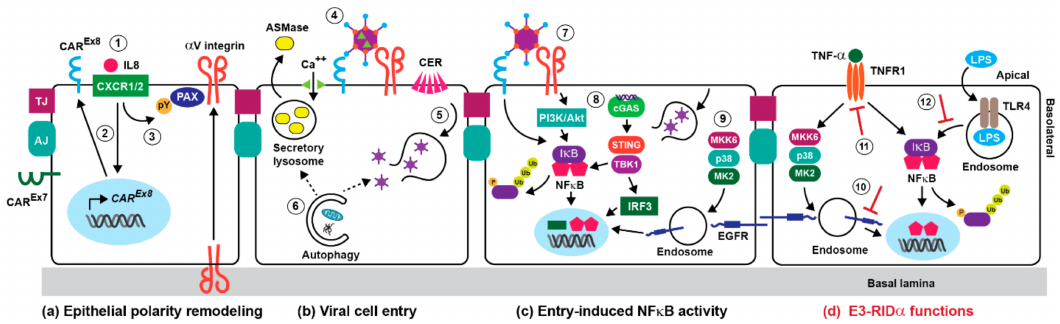
Figure 1. Adenovirus-directed innate immunity through nuclear factor kappa-light-chain-enhancer of activated B cells (NF κ B). ( a ) Adenovirus induces host cell secretion of IL-8 (1), which regulates epithelial polarity of Car Ex8 (2) and α V integrins (3), allowing adenovirus entry from apical surface of respiratory epithelial cells. ( b ) Host cell receptor binding also unmasks the viral membrane lytic protein-VI (green triangle), which activates a membrane repair system leading to the generation of plasma membrane ceramide lipids (4). Ceramides promote virus internalization and endosomal membrane penetration (5). Viral cell entry is also enhanced by elevated levels of autophagy via hypothetical mechanisms discussed in the text (6). ( c ) Adenovirus binding to host cell receptors elicits a first wave of NF κ B activity (7). Endosomal penetration also contributes to NF κ B activity through a cGAS-STING cytosolic DNA sensing pathway (8), and a p38-MAPK signaling cascade capable